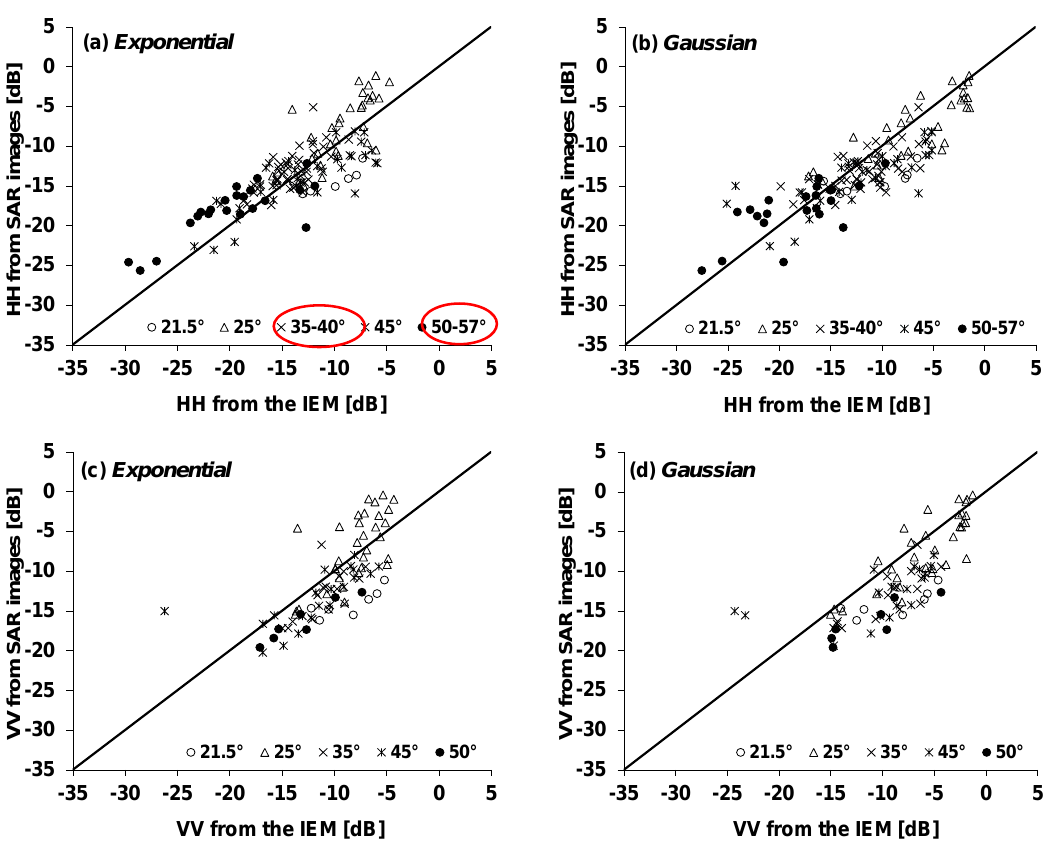
Figure 2. Observed backscatter coefficients from Synthetic Aperture Radar (SAR) images (L-band) vs . modeled backscatter values from IEM (at different incidence angles) using correlation length measurements, for exponential and Gaussian autocorrelation function (ACFs). Mean of the difference between SAR and IEM and root mean square error were calculated for all rms values. ( a ): HH polarization and exponential ACF, ( b ): HH polarization and Gaussian ACF, ( c ): VV polarization and exponential ACF, ( d ): VV polarization and Gaussian